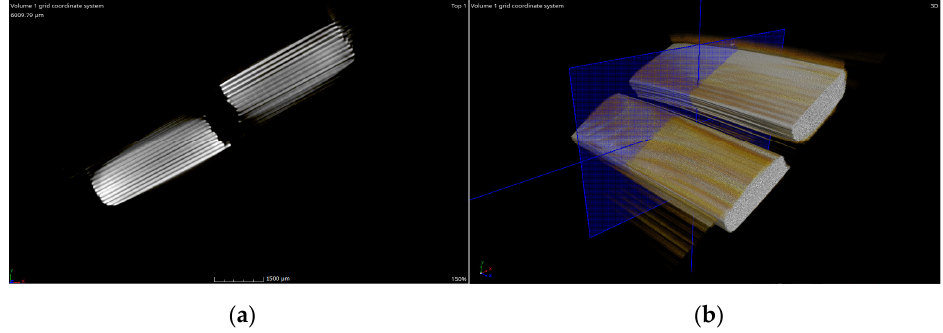
Figure 5. A tomogram slice of the HTS coil ( a ) and its location on the volumetric image ( b ).